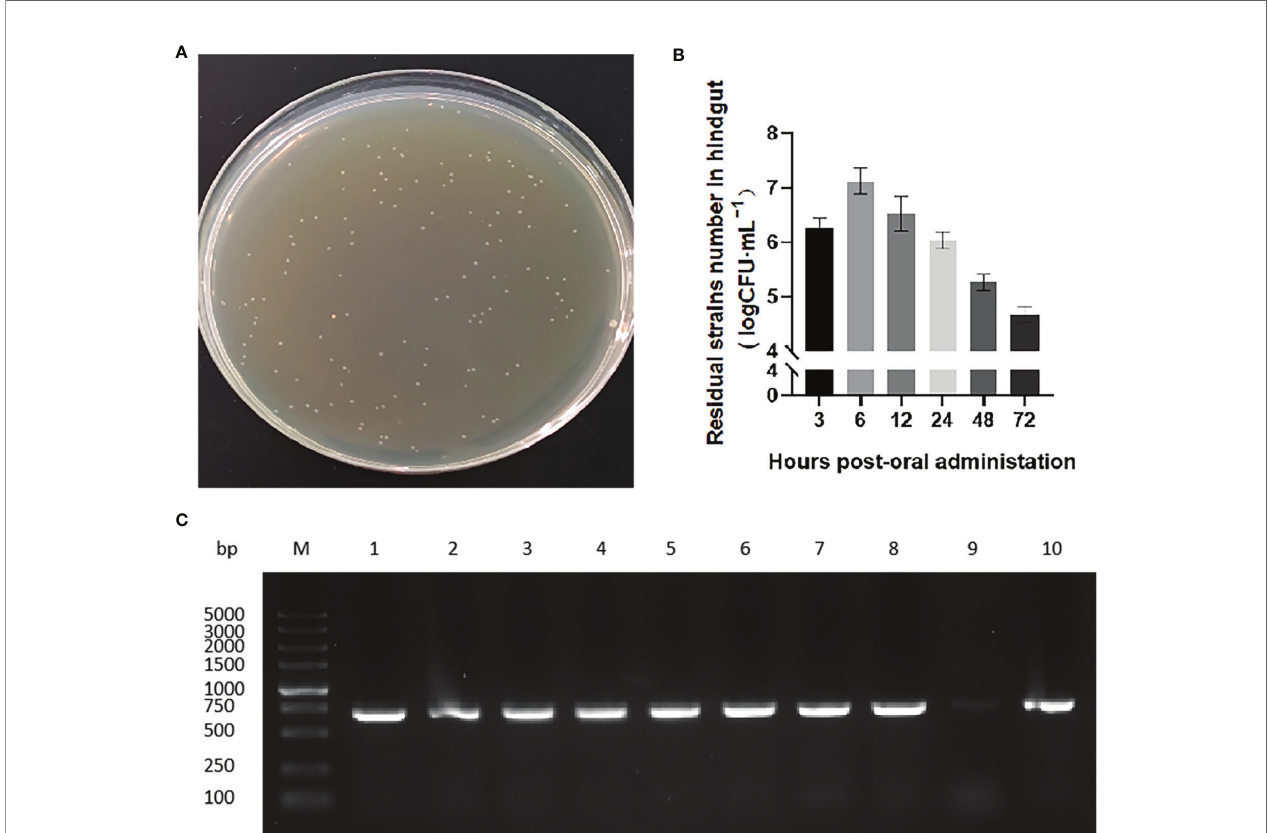
FIGURE 3 | Colonization of strains in rare minnow intestinal tract. (A) Recombinant strain colonies in pNZ8148- VP6 group that grew on chloramphenicol M17 agar plates. (B) Colony counts obtained from hindgut tissues collected at the indicated time points following immunization. The data represent means ± SEM of 3 fi sh.